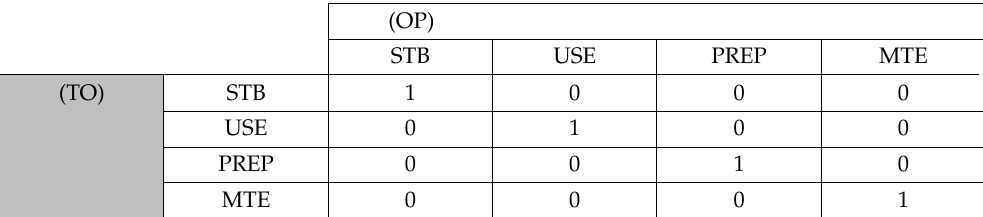
Figure 5. Algorithm applied to search for optimal strategies in the set of possible strategies of the (OP) and (TO) sub-systems in the game-based system (GS), adapted from [33]. In order to verify the presented algorithm, a simulation based on a Bayesian network has been developed. Considering data availability, only an experimental (reduced) dataset has been used; however, all the variables have been discretized and selected for the Bayesian network structure learning and parameter learning, according to the BN rules. The structured set of possible strategies (OP/TO) as a matrix (Cxj) has been calculated and presented in Table 1. Table 1. Matrix (Cxj) set of possible strategies (OP) and (TO).